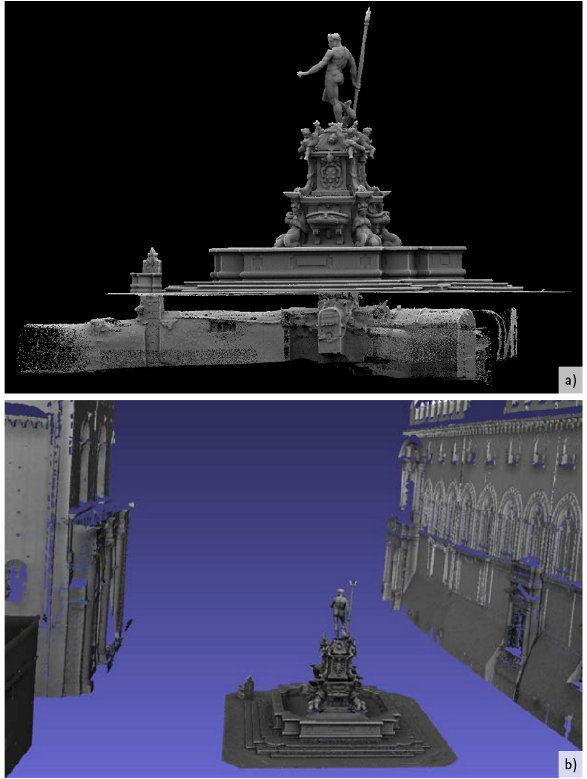
Figure 4. Point cloud of the Fountain of the Neptune (above and under-ground), obtained by the terrestrial laser scanning (a); the 3D model (low resolution) and surrounding buildings (b).